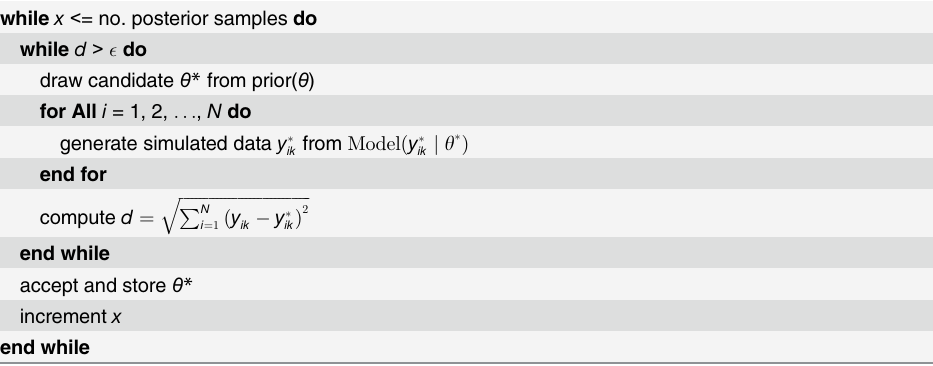
Table 1. Pseudocode of ABC rejection sampling